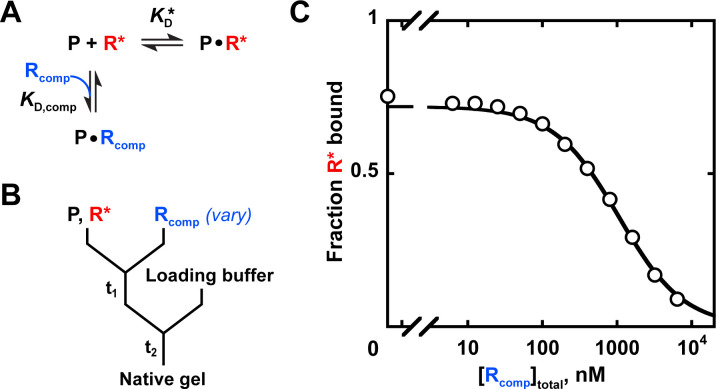
Measuring binding affinity by competition.(A) Competitive binding reaction scheme. R*: labeled RNA ligand; Rcomp: unlabeled competitor RNA; KD*: protein affinity for R*; KD,comp: protein affinity for Rcomp. (B) Mixing scheme for a competition measurement. (C) Competition between the U1C point mutant of the Puf4 consensus (Rcomp = CGUAUAUUA) and the labeled consensus RNA (R*= 32P-AUGUGUAUAUUAGU). The data were fit to the following equation (Lin and Riggs, 1972; Weeks and Crothers, 1992):(9)Fraction bound =A ×12[R∗]total[KD∗+ KD∗KD,comp[Rcomp]total+[P]total+ [R∗]total− (KD∗+ KD∗KD,comp[Rcomp]total+[P]total+ [R∗]total)2 − 4[R∗]total[P]total]+OA indicates the maximum amplitude, constrained to the fit amplitude of the R* binding curve that is measured in parallel by a direct binding experiment (A = 0.89 for Puf4 binding to R*). O is the y axis offset (background). [R*]total was constrained to the lower limit of the labeled RNA concentration. KD* was constrained to Puf4 affinity for the labeled RNA, as determined by direct measurement in the same experiment (0.105 nM, after accounting for active protein fraction of 75%). [P]total was 0.45 nM, after accounting for active protein fraction. The fit KD,comp value was 204 nM. Incubation times of 10, 30, and 110 min gave consistent KD,comp values (190–210 nM), as did lowering the protein concentration by three-fold (180 nM). Equation 9 is applicable only for KD,comp >> KD*. For other cases see Wang, 1995.